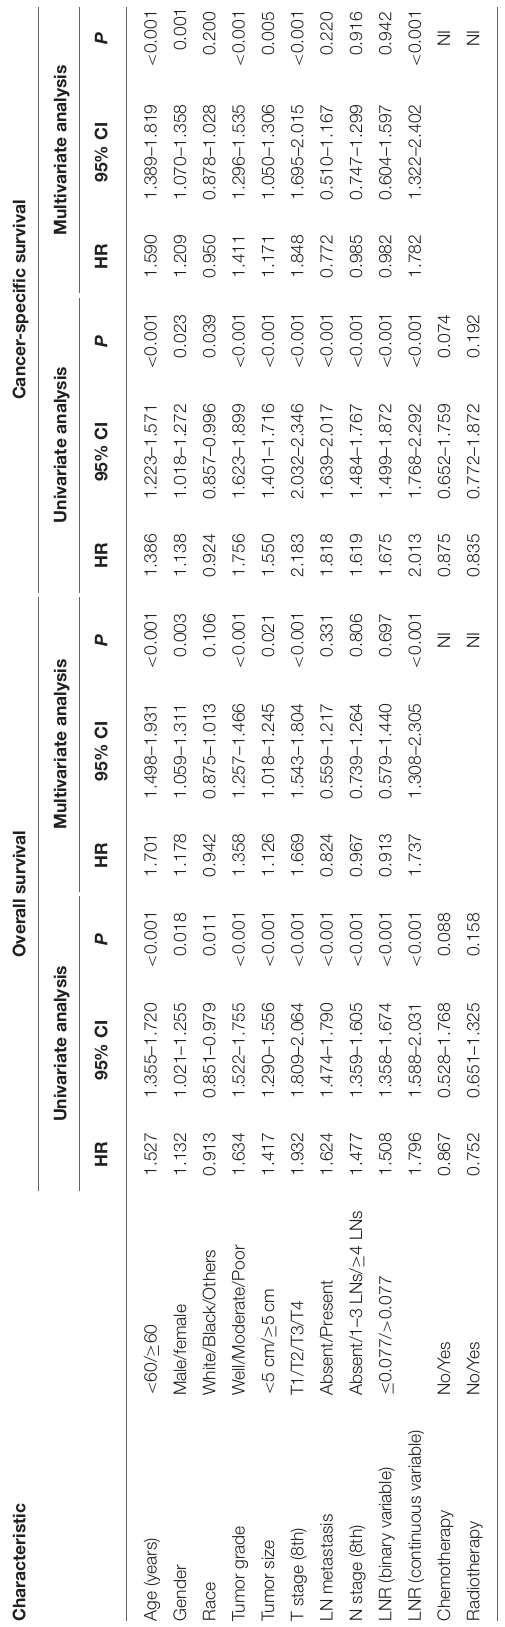
Figure 6 . For the training cohort, the area under ROC curve (AUC) values of the nomogram for predicting the 1-, 2-, and 3- year OS rates were 0.732, 0.752, and 0.765, and 0.704, 0.731, and 0.736 for the 8th TNM staging system, respectively. With regard to the prediction of the 1-, 2-, and 3-year CSS rates, higher AUC values were observed for the nomogram compared with the 8th TNM staging system. Similar results were also obtained for the internal and external validation cohort ( Table 4